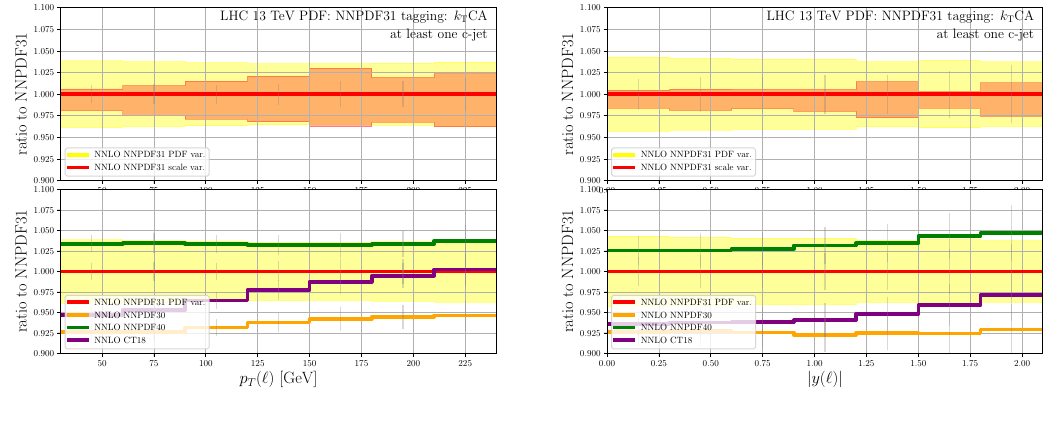
Figure 5 . Ratio of differential distributions in the transverse momentum of the charged lepton (left) and the rapidity of the charged lepton (right) for the process pp → W + j The top panels show a comparison of 7-points scale variation against PDF error. The lower panels show the PDF error for the NNPDF3.1 set compared to the central predictions of the NNPDF3.0, NNPDF4.0, and CT18